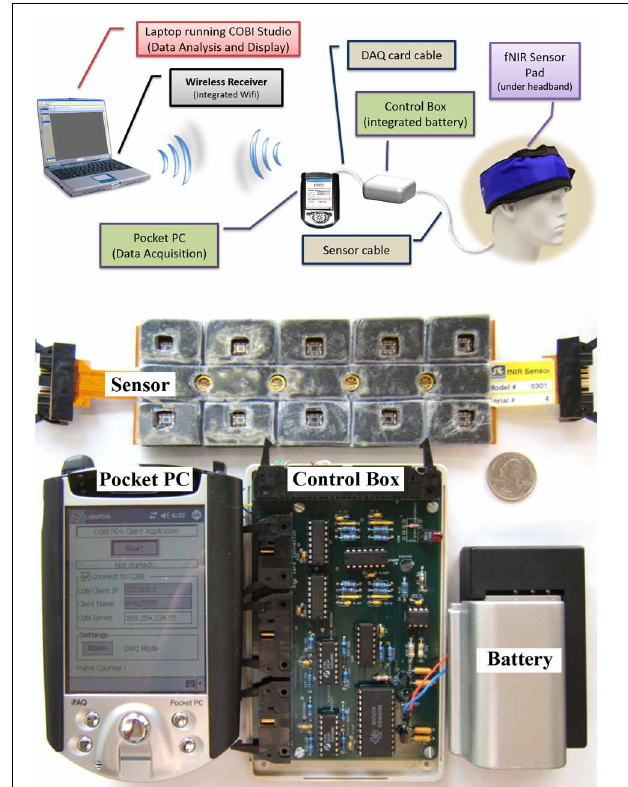
FIGURE 8 | General design concept (top) and implemented system components displaying 16-channel prefrontal cortex probe, pocket pc, control box, and battery (bottom). A quarter (US $0.25 piece) is also included for size comparison.